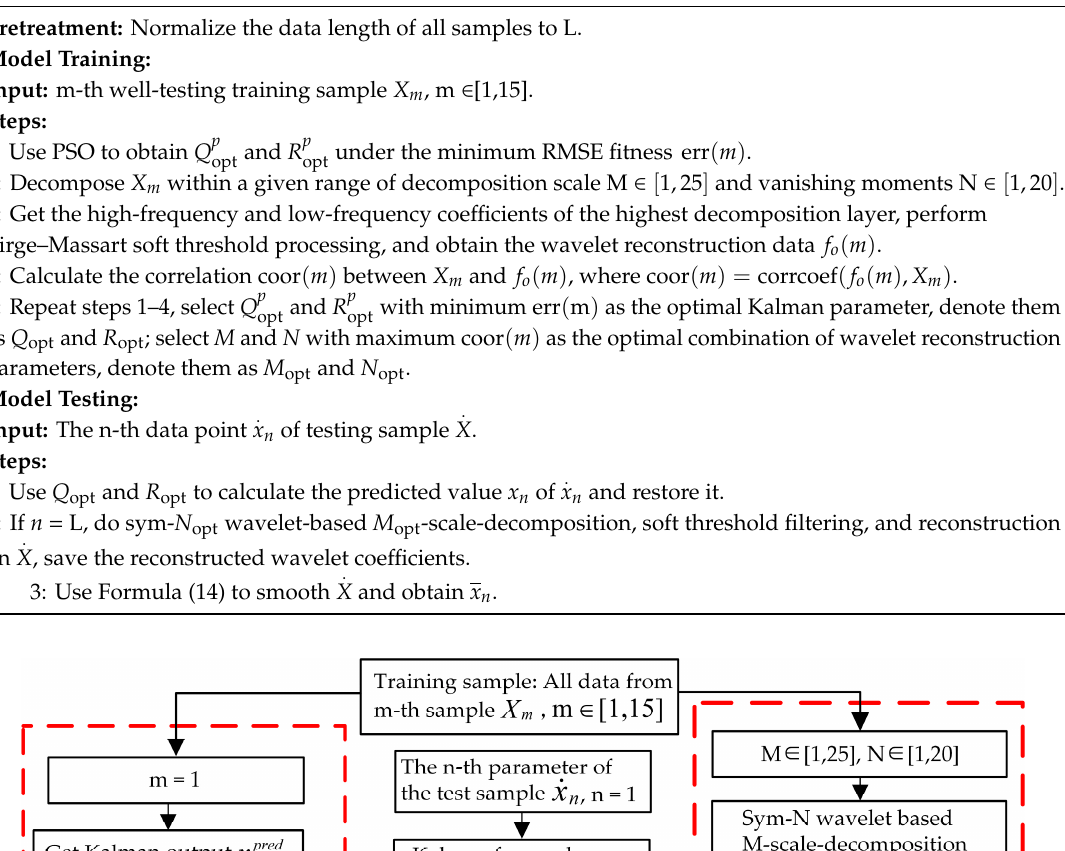
Algorithm 1 WBKS algorithm